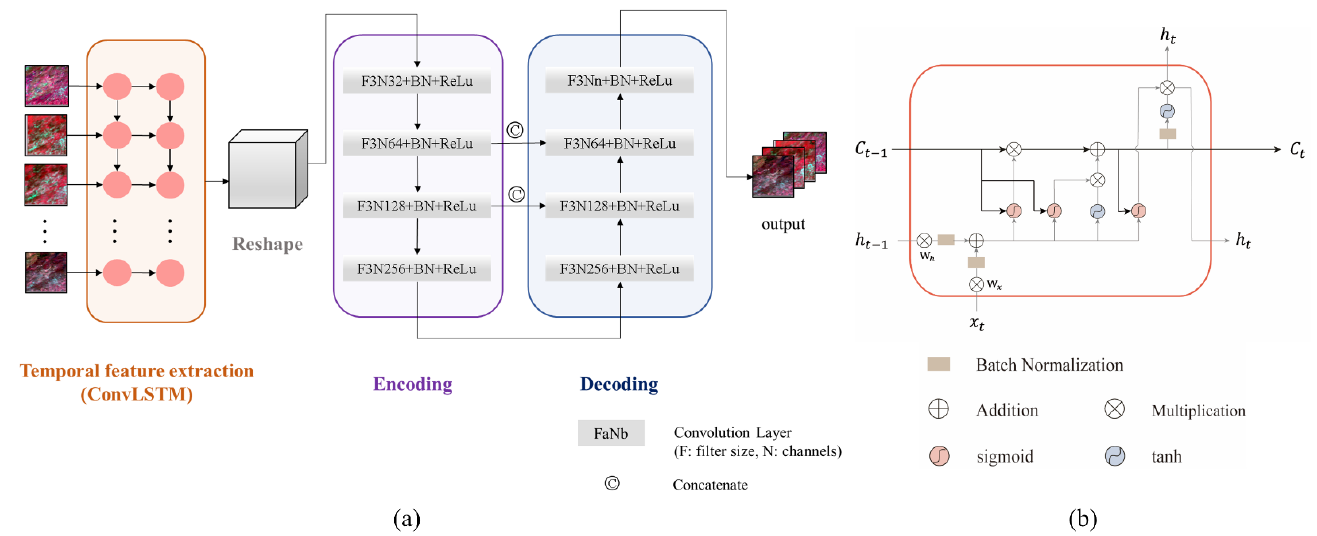
Figure 4. The structure of ( a ) the sequence-texture generation networks proposed in this study, ( b ) the ConvLSTM cell.